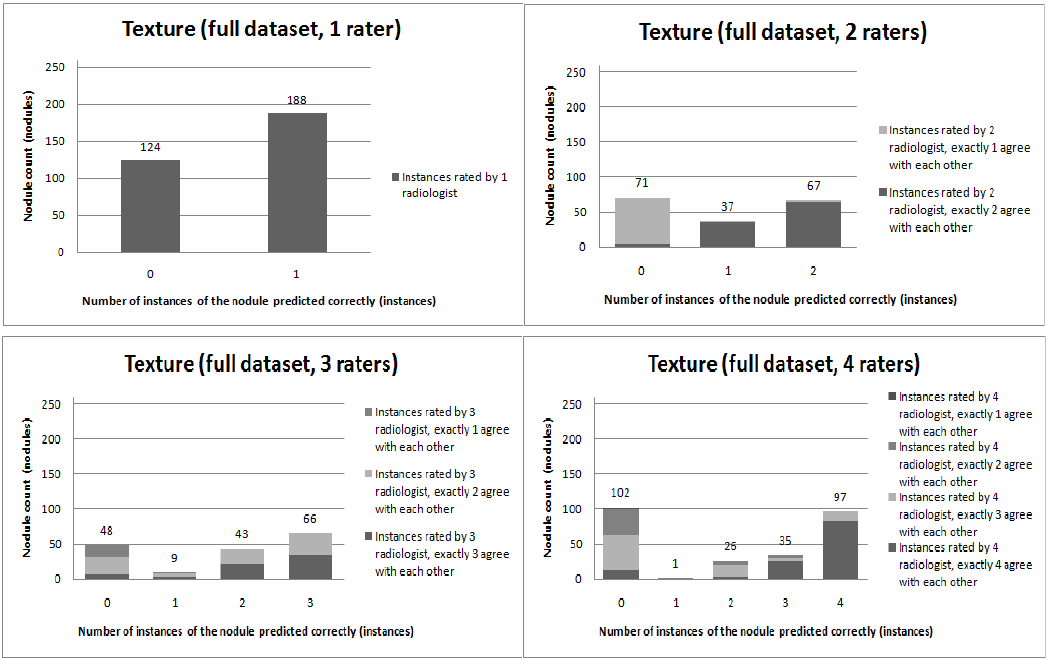
Figure 12. Visual overview of the ensemble of classifiers’ agreement with the panel of experts’ opinions